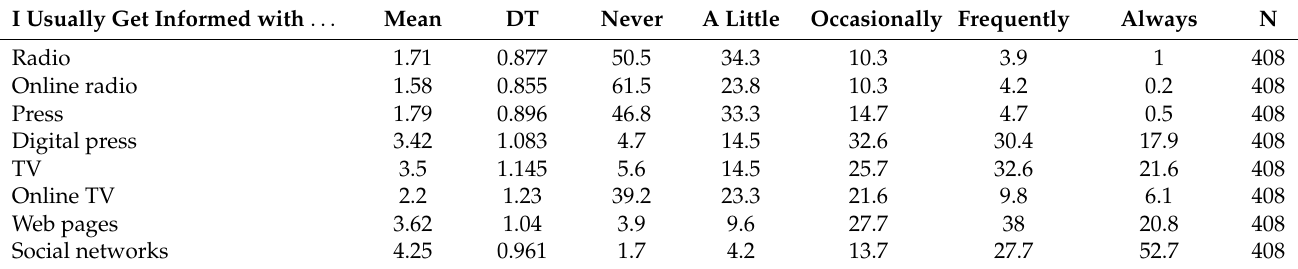
Table 2. Basic statistics for media normally consume to be informed by Generation Z. Own elaboration. I Usually Get Informed with . . .